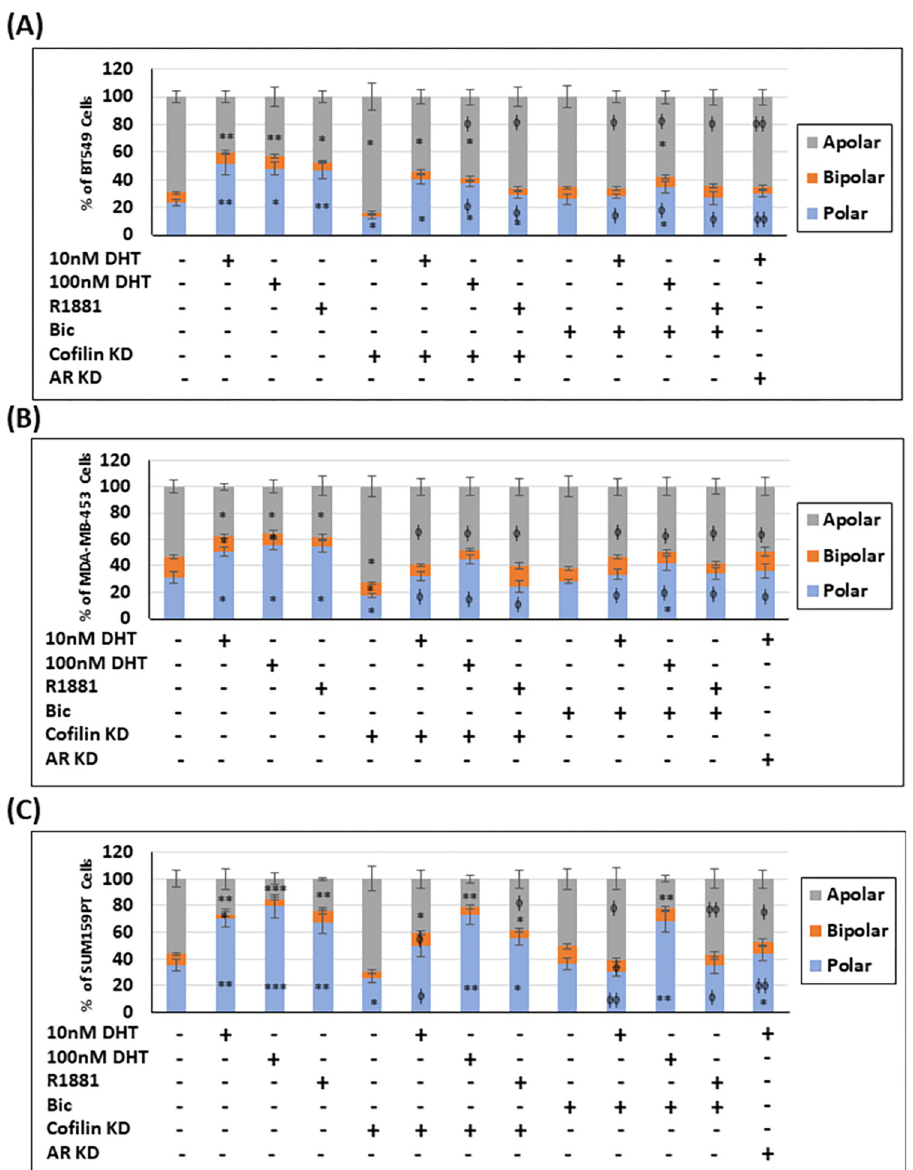
Fig 6. Knocking down cofilin in androgen-treated MDA-MB-453 cells restored the control polarization phenotype but not in BT549 or SUM159PT cells. Control and treated TNBC cells were stained with fluorescent- conjugated phalloidin and categorized as apolar, bipolar or polar (see S5 Fig), and the percentage of cells in each category was scored in BT549 cells (A), MDA-MB-543 cells (B), and SUM159PT cells (C) and presented as percentage of total cells. Data are expressed as mean ± SEM, n � 100 cells in each experiment, three independent experiments. � p < 0.05, �� p < 0.01, ��� p < 0.001 versus control, ϕ p < 0.05, ϕ ϕ p < 0.01 versus androgen-treated cells. DHT (Fig 7M and 7O and S7 Fig). SUM159PT cells did not show any significant effect of androgens on focal adhesion area, nor did inclusion of bicalutamide or silencing AR signifi- cantly alter adhesions in SUM159PT cells (Fig 7Q). However, all three cell lines showed increased focal adhesion areas upon cofilin KD. Androgens fully reversed the effects of silenc- ing cofilin expression in BT549 cells, but not in MDA-MB-453 and SUM159PT cell lines (Fig 7M, 7O and 7Q and S7 Fig), again suggesting the AR-dependent differences in signaling